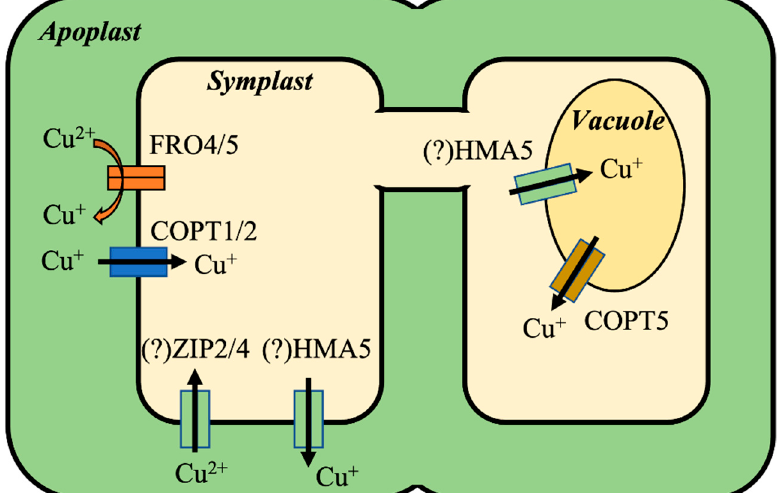
Figure 2. Representation of Arabidopsis thaliana Cu uptake and vacuolar Cu transport in a root cell. Cu 2+ is reduced to Cu + by extracellular, membrane-bound reductases AtFRO4/AtFRO5 in the rhizosphere. Cu + is transported into root cells by high affinity transporters AtCOPT1 and AtCOPT2. Possible uptake of Cu 2+ by AtZIP2 and/or AtZIP4 is also represented. AtHMA5 Cu detoxification by either vacuolar internalization or plasma membrane efflux is shown. AtCOPT5, which is located in both pre-vacuolar compartments and tonoplast, is involved in Cu transport from the vacuole to the cytoplasm. Two generic cells connected by plasmodesmata are represented to accommodate depictions of both plasma membrane and vacuolar transporters.